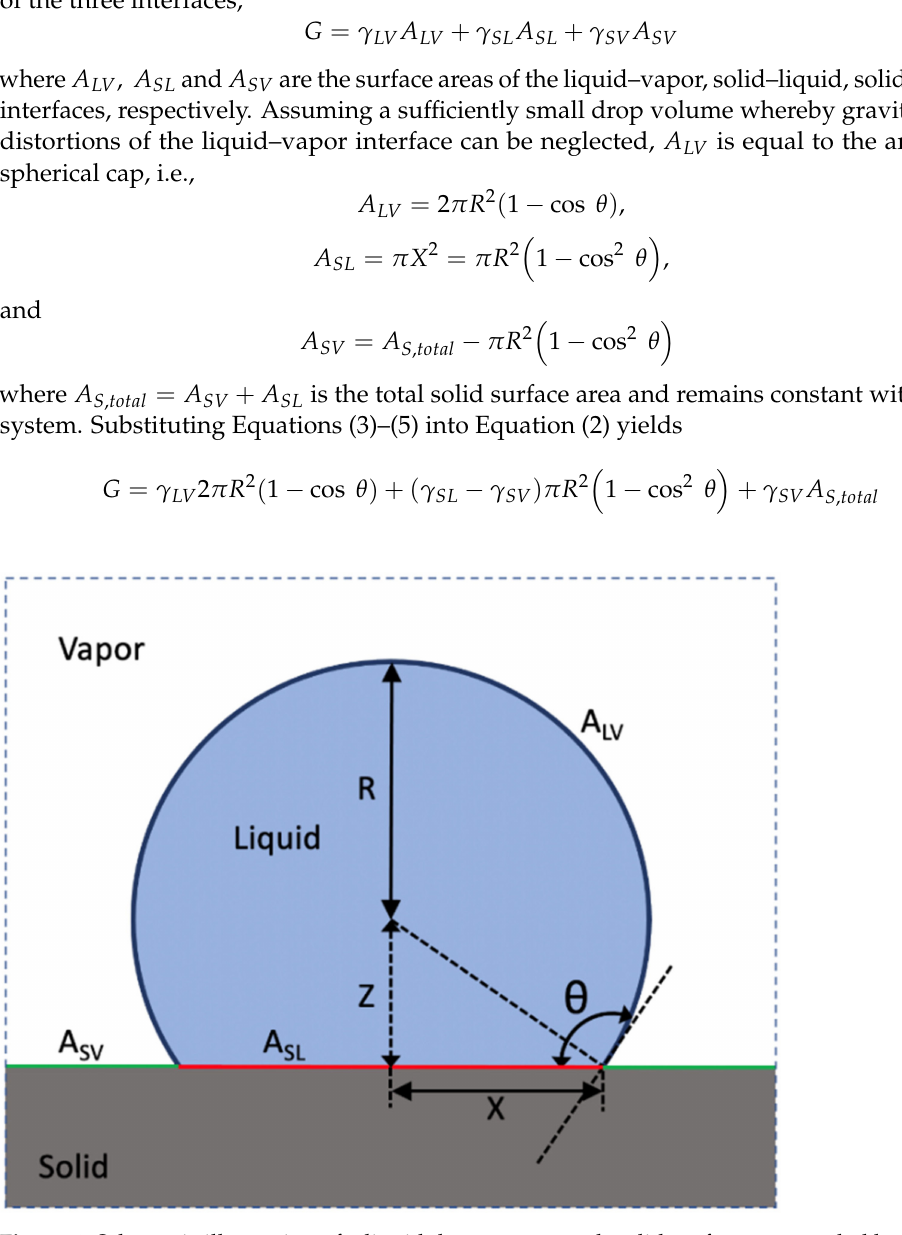
Figure 4. Schematic illustration of a liquid drop on a smooth solid surface surrounded by a vapor phase. The dashed box denotes the system. The liquid drop can either wet or de-wet the solid surface (i.e., a change in θ and R ) with the constraint of a fixed liquid drop volume. Equilibrium is achieved when the free energy of the system is